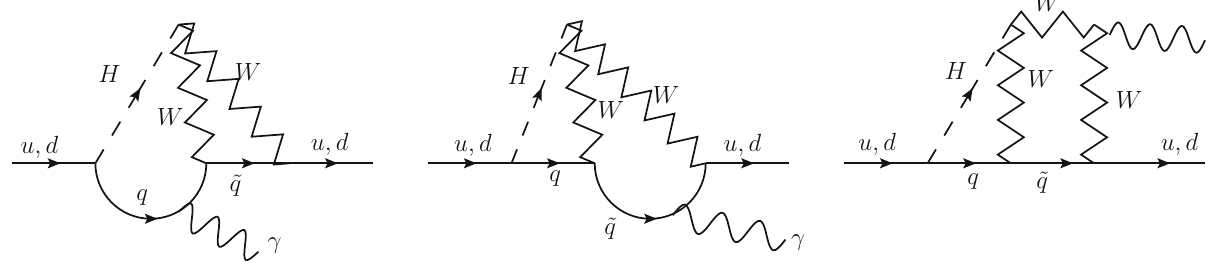
due to momentum integration, or are suppressed by small light quark masses. The ( c ) diagrams are complex conjugates of the ( a ) diagrams . Here q = s , b and ˜ q = u , c , t for EDM of a d -quark, and q = c , t and ˜ q = d , s , b for EDM of a u -quark